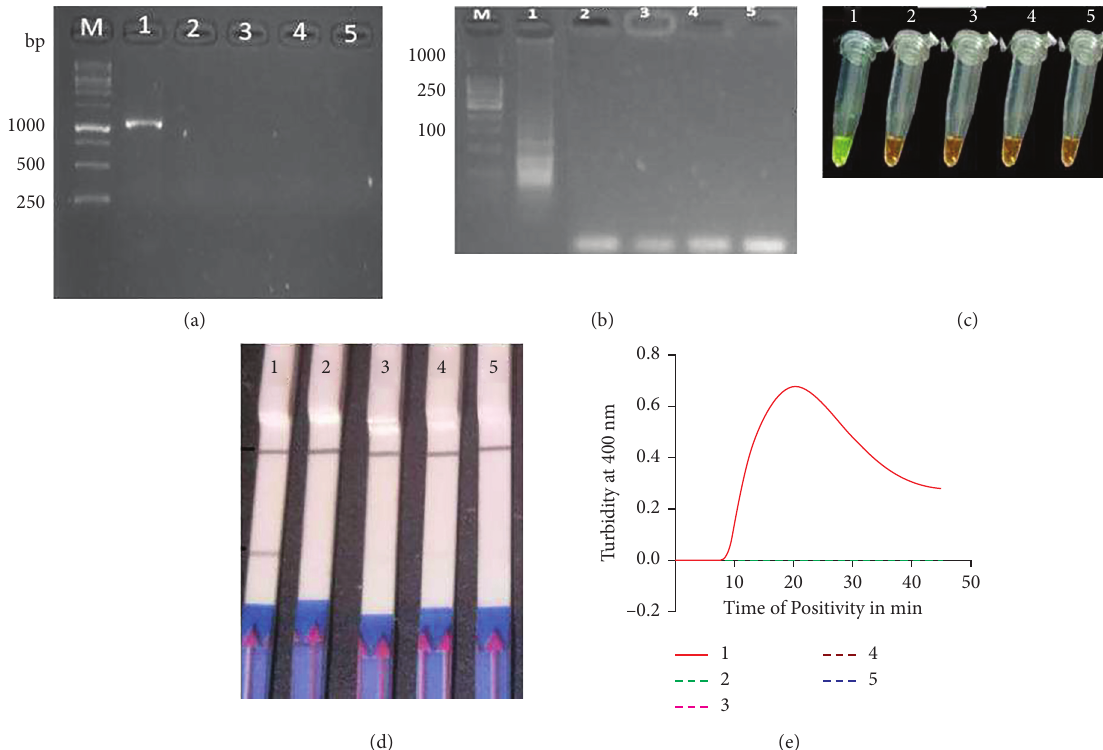
Figure 5: Specificity test. Nested PCR products analysis on 1.5% agarose gel (a); LAMP products analysis on 3% agarose gel (b); SYBR green visual detection (c); LAMP-LFD test (d); real-time turbidity monitoring (e). CL and TL are control and test lines, respectively. Lane M: DNA molecular marker; tube 1 represents E granulosus DNA template; tubes 2, 3, and 4 represent DNA templates from T. saginata, T. solium, and F. hepatica, respectively, while tube 5 represents the no template control. Table 2: Comparison between LAMP-LFD and nested PCR tests for detection of E . granulosus from fertile and infertile cysts. Type of samples LAMP-LFD results Nested PCR